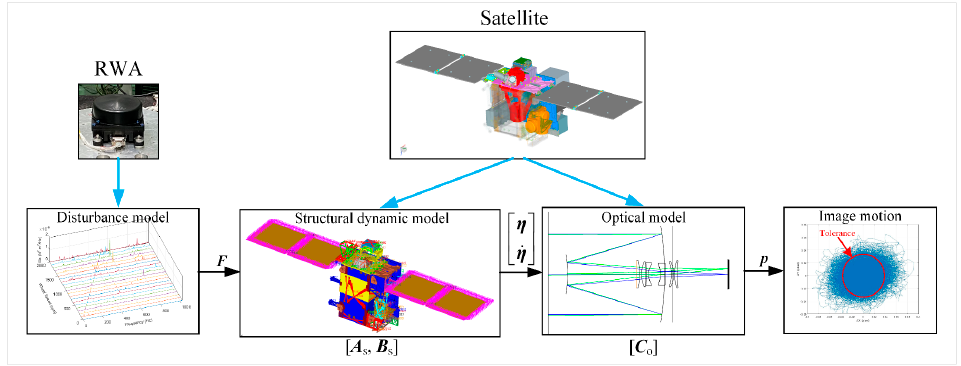
Figure 3. Block diagram of the integrated model.